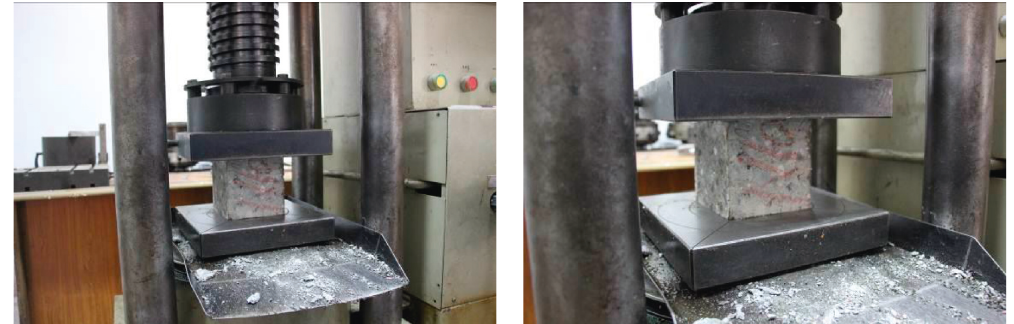
Figure 4: Strength test with constant stress testing